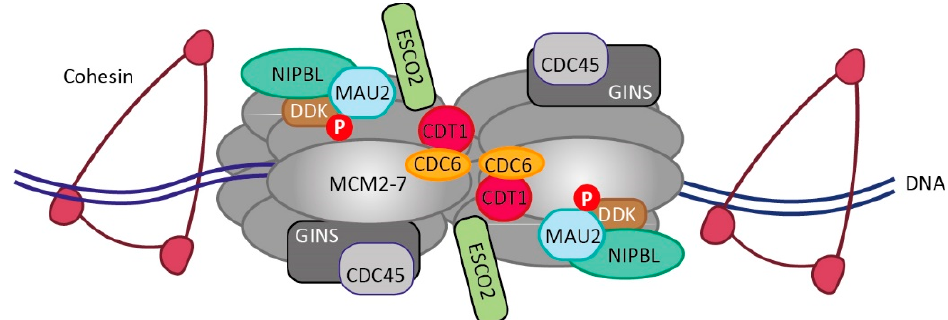
Figure 1. The pre-RC complex interacts with multiple cohesion factors. Origins of replication on DNA are marked by multi-subunit ORC complexes (not shown), which, in concert with CDT6 and CDT1, load MCM2-7 complexes onto DNA as double hexamers. DDK-dependent phosphorylation promotes binding of the cohesin loader complex NIPBL-MAU2 and the cohesin complex to pre-RCs. Recruitment of the acetyltransferase ESCO2 can occur prior to DNA replication via an interaction with MCM2-7. In S-phase, phosphorylation of MCM further stimulates CMG assembly (CDC45-MCM-GINS) and subsequent DNA replication. For further explanation, see text.